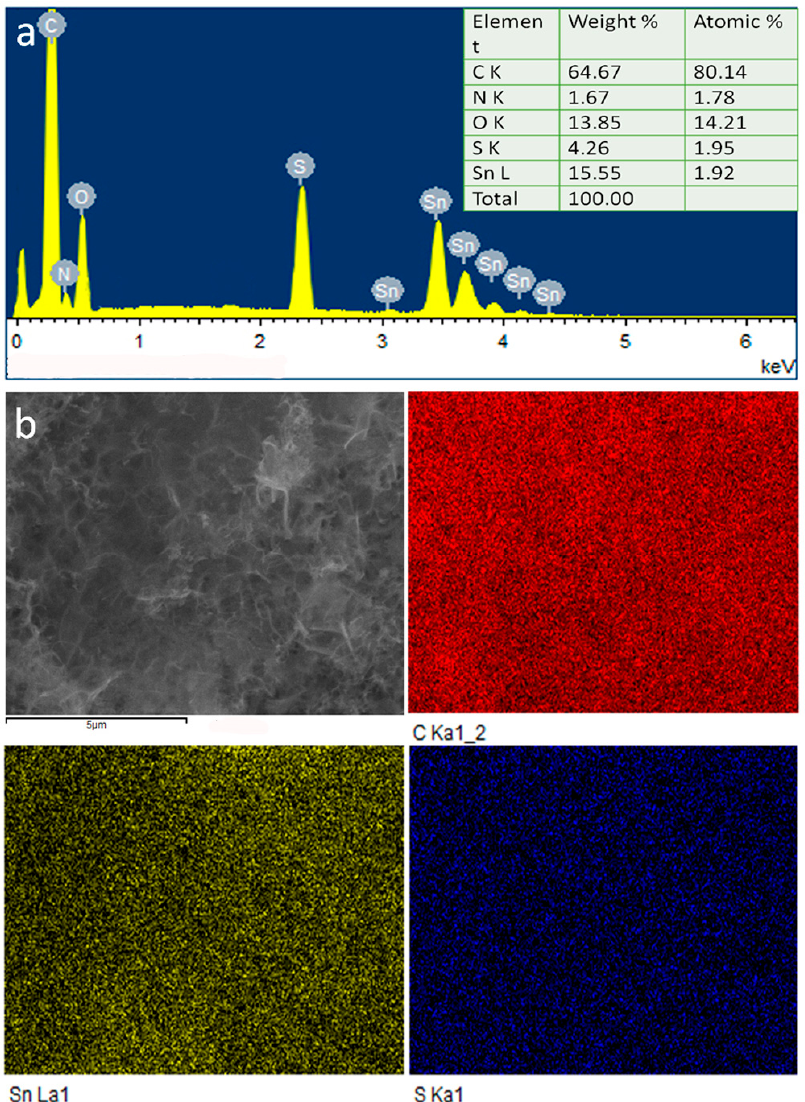
Figure 3. Energy-dispersive spectra EDS spectrum ( a ) and EDS elemental mapping ( b ) of C, Sn and S elements for SnS@C composites.